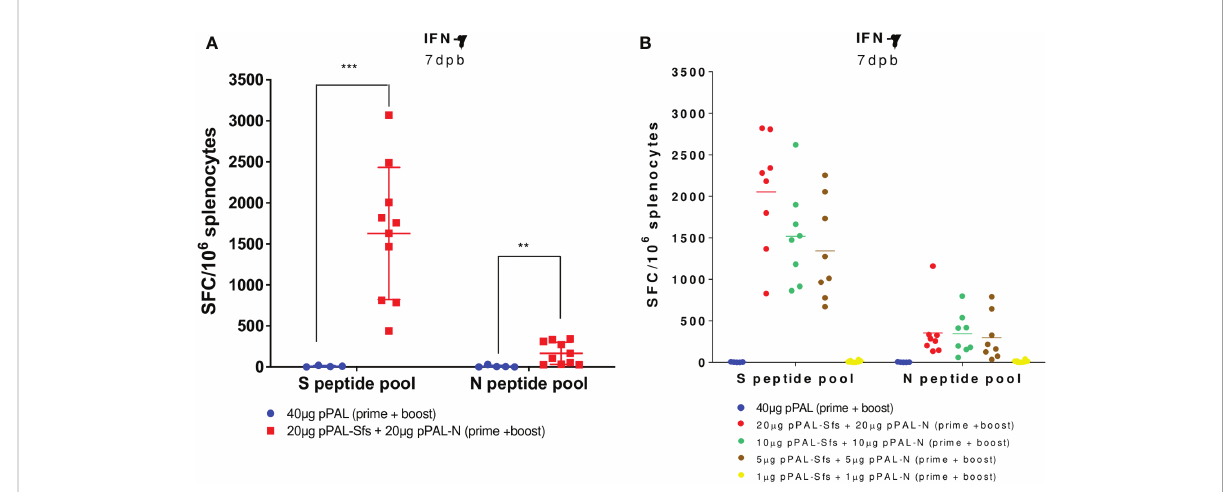
FIGURE 3 S- and N-speci fi c activation of IFN- g -producing splenocytes induced by the pPAL-Sfs + pPAL-N vaccine candidate in C57BL/6J mice is dose- dependent. Splenocytes were obtained 7 days post-boost after prime/boost inoculation of pPAL and pPAL-Sfs + pPAL-N. Splenocytes (2x10 5 cells/well) were stimulated at 37 °C in IFN- g ELISpot plates for 16 h with 11-mer 8 amino acid-overlap peptide pools (25 µg/well) representing the whole S and N amino acid sequences in equimolar amounts. Negative stimulation controls were subtracted from the SFC per million cell values. Statistical inference was performed using the Student ’ s t-test applying p-value adjustment by the Holm-Sidak method ( a = 0.05; **p<0.01; ***p<0.001). (A) Robust S- and N-speci fi c activation of IFN- g -producing splenocytes is observed with a prime/boost immunization regime with pPAL-Sfs + pPAL-N. (B) S-speci fi c activation of IFN- g -producing splenocytes with pPAL-Sfs + pPAL-N is dose